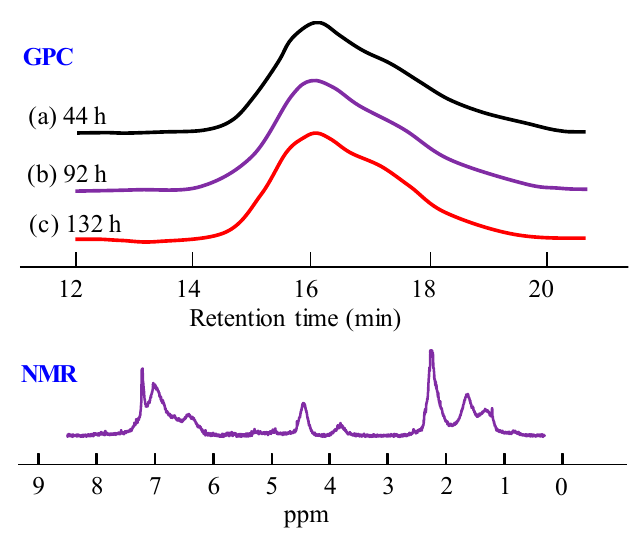
Figure 3. GPC and NMR results of the extracted materials from the ETFE- g -poly(CMS) film. The 1 H NMR spectra of the residue showed broad signals at 1.2–2.0, 4.0–5.0, and 6.0–8.0 ppm,